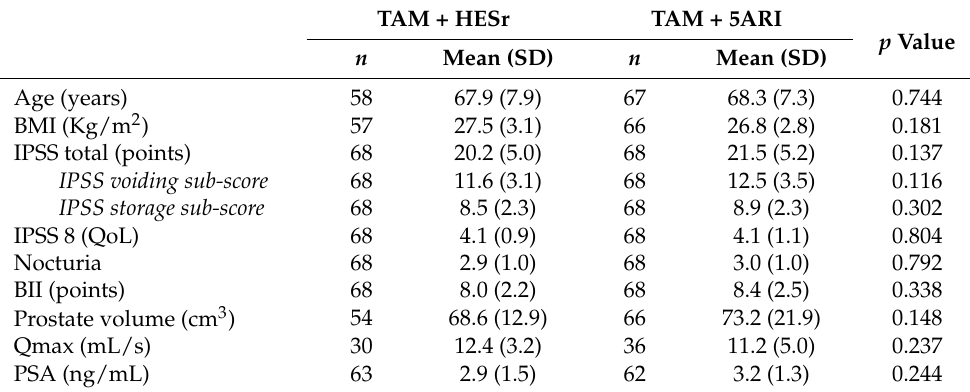
Table 1. Patient baseline characteristics by treatment group (iterative matching sample).